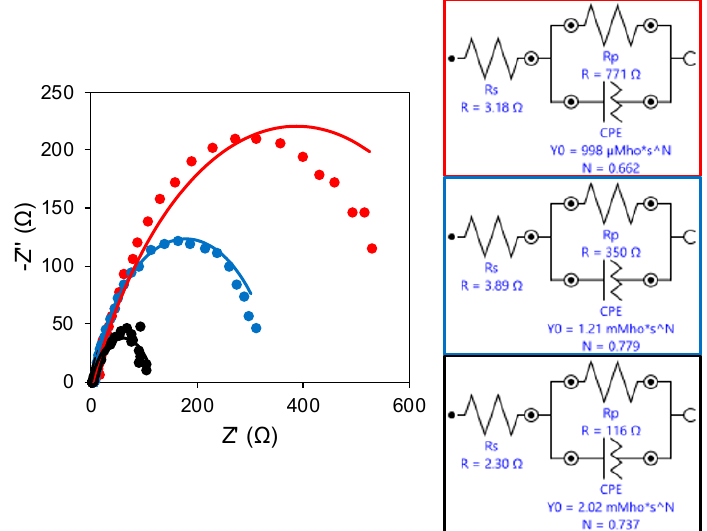
Figure 6. Nyquist data (dots) and equivalent circuit adjustment fit (line) on the left and simulated electrochemical circuit at right of TiO 2 (red), Fe 3 O 4 –SiO 2 –TiO 2 (blue) and Fe 3 O 4 (black) catalysts.